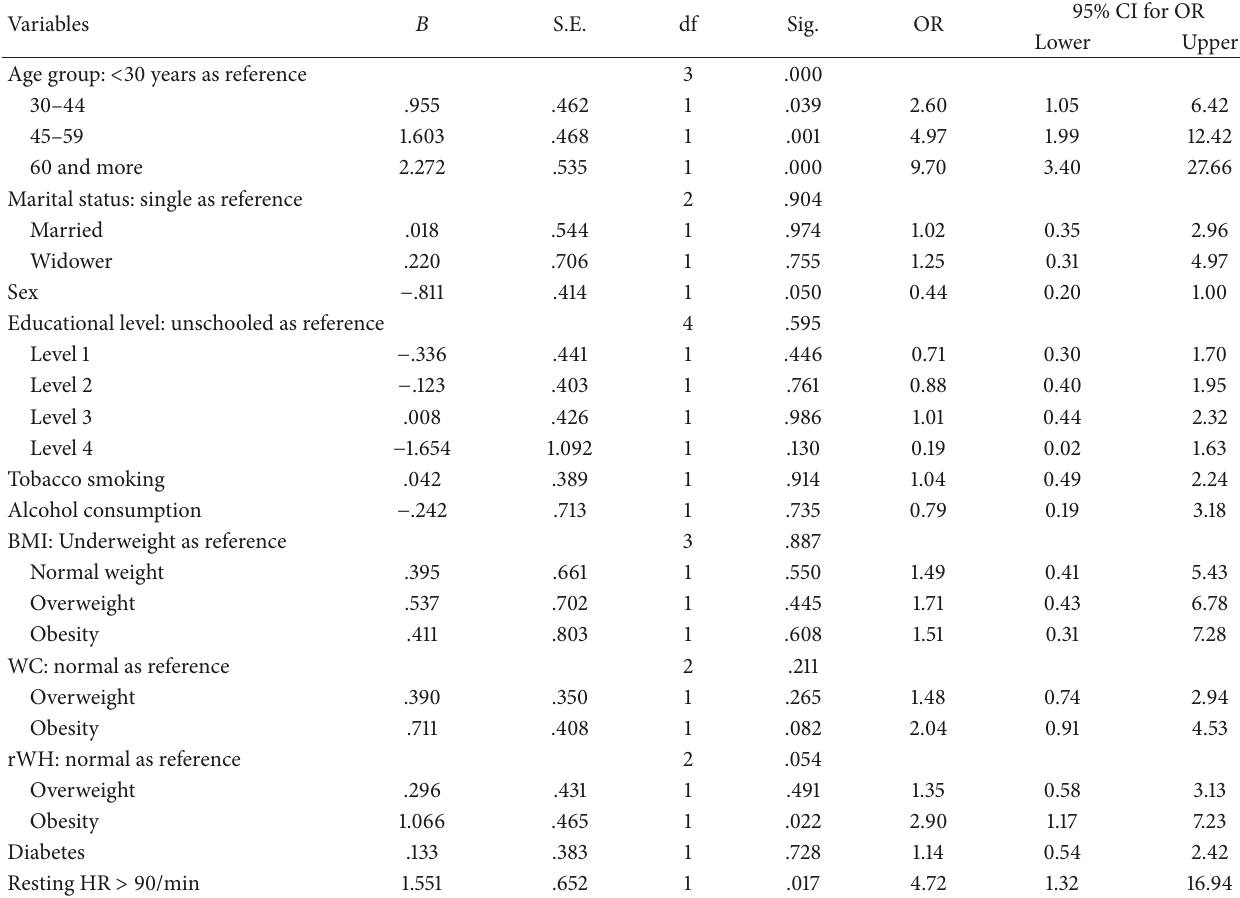
Table 5: Logistic regression predicting hypertension in rural